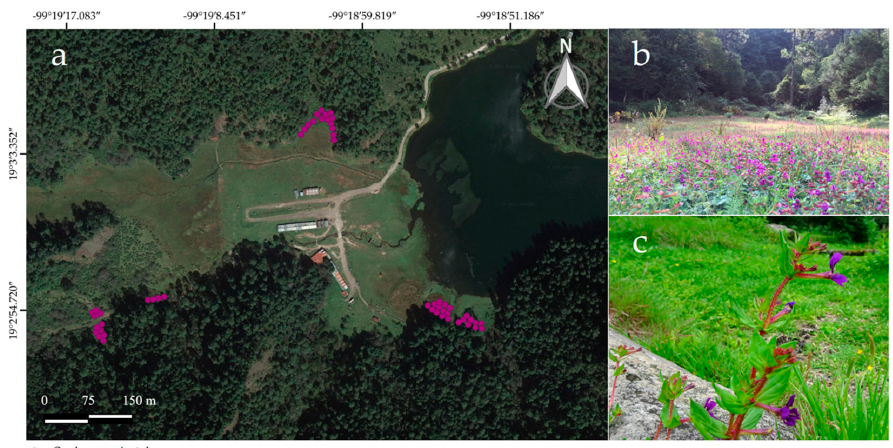
Figure 1. Wild populations of Cuphea aequipetala Cav. growing in the Lagunas de Zempoala National Park. ( a ) Map with the location of the populations in the recreation area; ( b ) wild population; ( c ) wild plant.